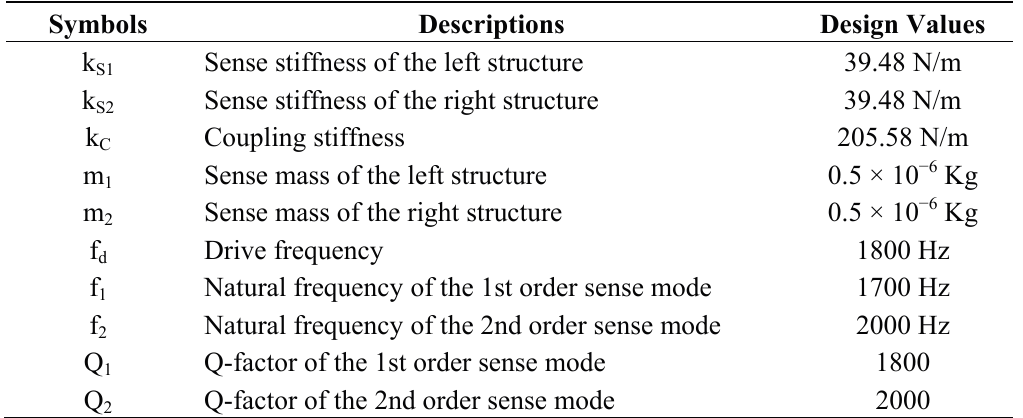
Table 1. Design parameters of the tuning fork micro-gyroscope taken as an example.